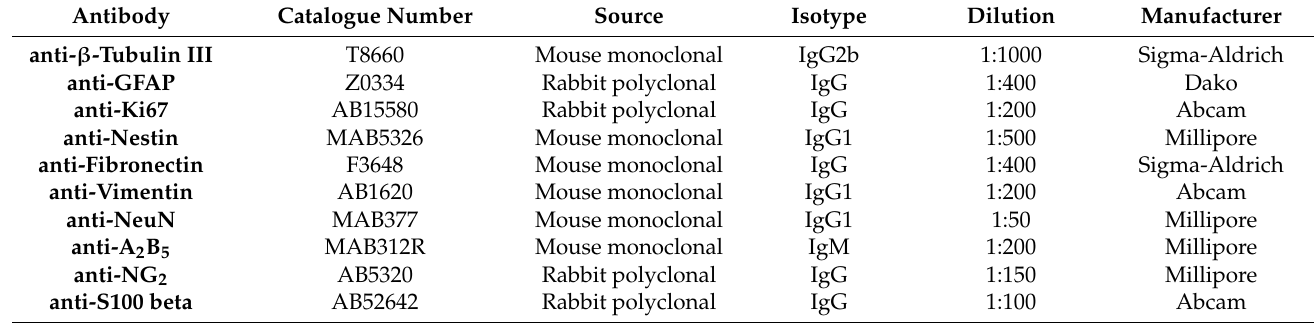
Table 2. Primary antibodies used in immunocytochemistry analysis.